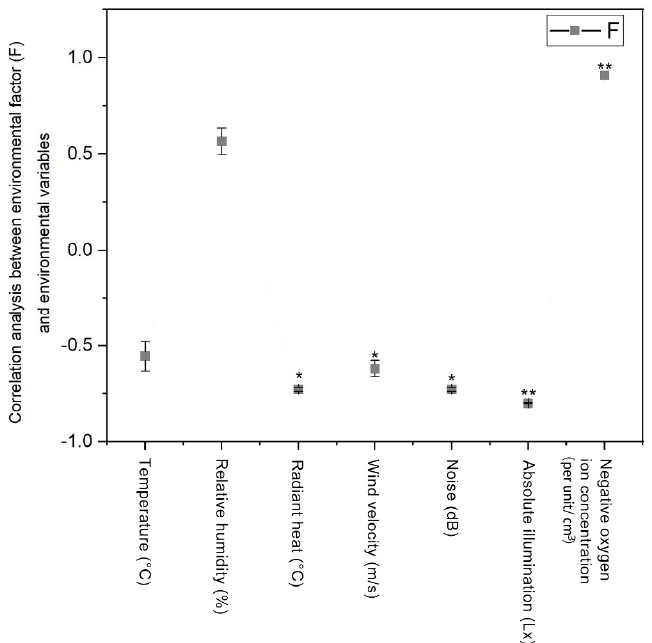
Figure 5. The spatial and sensory factors identified by the SDM as they relate to the seven environmental factors. Data are presented as means ± SD; n = 348; * p < 0.05; ** p < 0.01; integrated environmental assessment factor score (F) = [sensory factor score (F1) x factor variance percentage senses + atmosphere factor score (F2) x atmosphere factor variance percentage + climate factor score (F3) x climate factor variance percentage + location factor score (F4) x place factor variance percentage + space factor score (F5) x space factor variance percentage] / percentage of the total variance, is obtained by computing the final composite scores of each environment